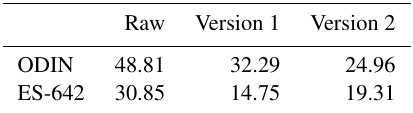
Table 2. Mean squared error (in µg 2 m − 6 ) between hourly ODIN or ES-642 data (for all three data versions) and data from the co- located TEOM at the St Albans sites using measurements made dur- ing the entire deployment period. The instrument ID for the ODIN instrument is “SD0025”, and for the ES-642 instrument the ID is